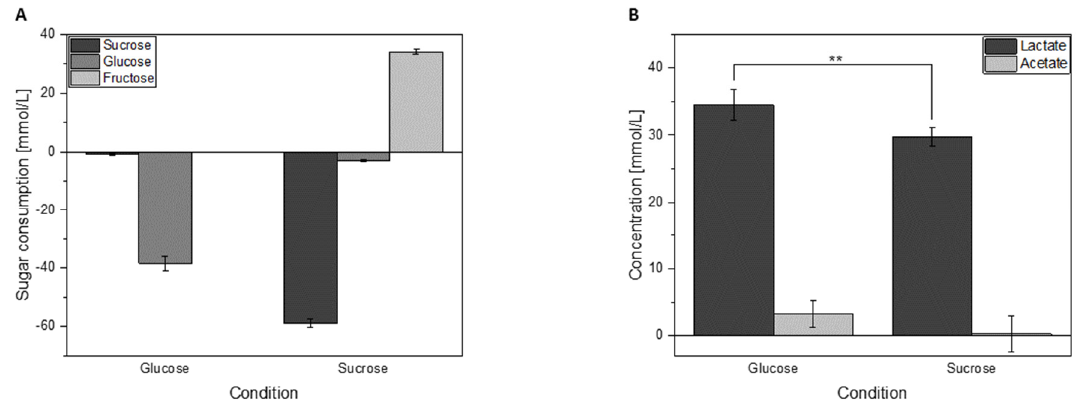
Figure 6. Sugar consumption ( A ) and acid formation ( B ) as quantified by HPLC analysis of culture supernatants from cells incubated in either glucose or sucrose. ** = p ≤ 0.01.